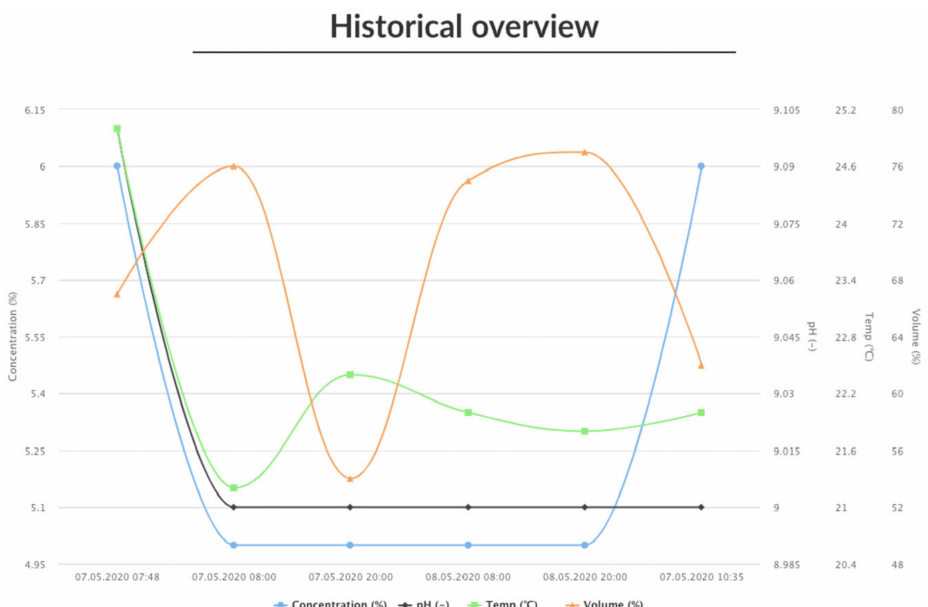
Figure 6. An example of a graphical representation of measured parameters in the web